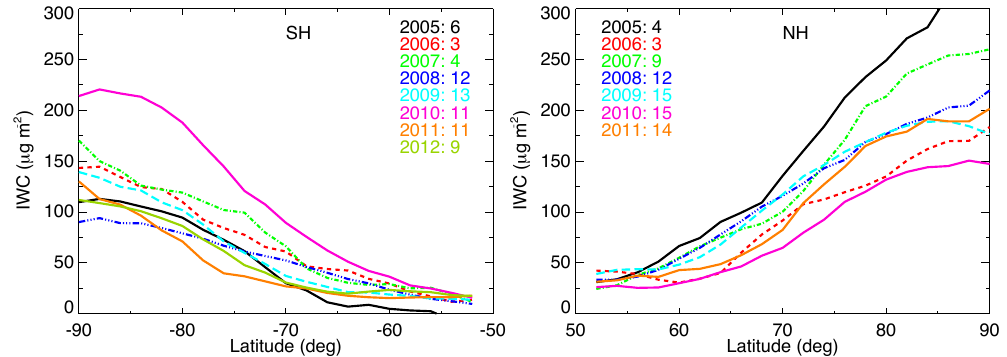
Figure 8. Latitudinal distribution of IWC of the PMC layers for the SH (left) and the NH (right) seasons for all measurements. The colours indicate the data for different years and the number of days measured per year (see Table 2).